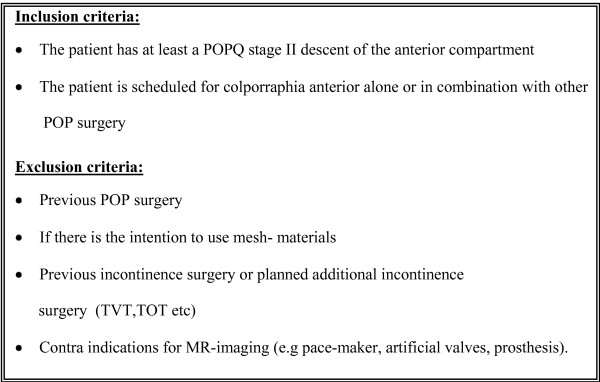
Study inclusion and exclusion criteria.